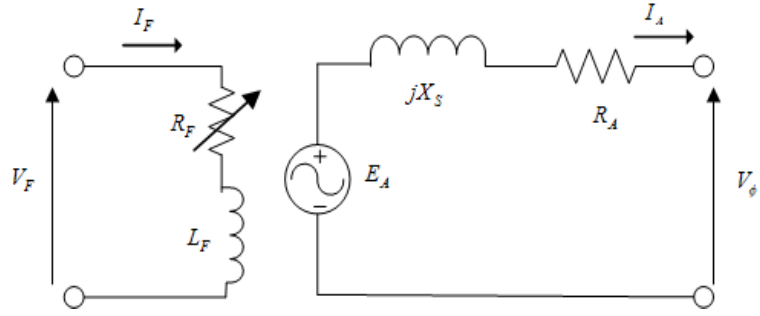
Figure 4. The pre-phase equivalent circuit for synchronous generator.